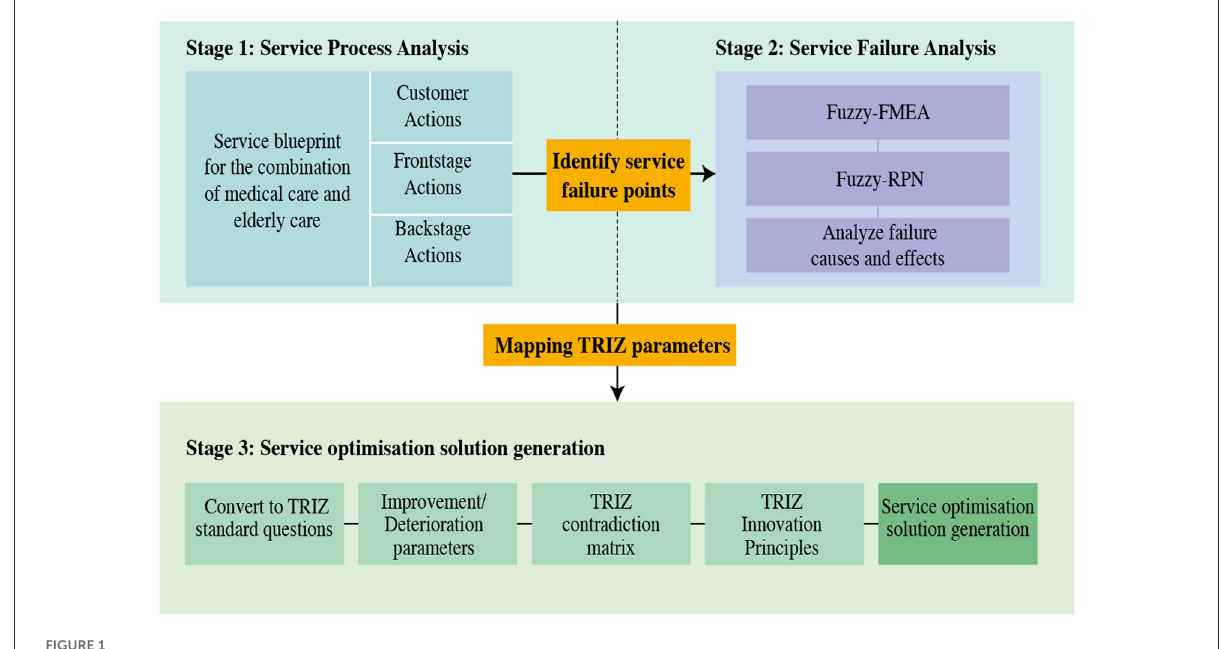
FIGURE1 Integrated service blueprint-TRIZ